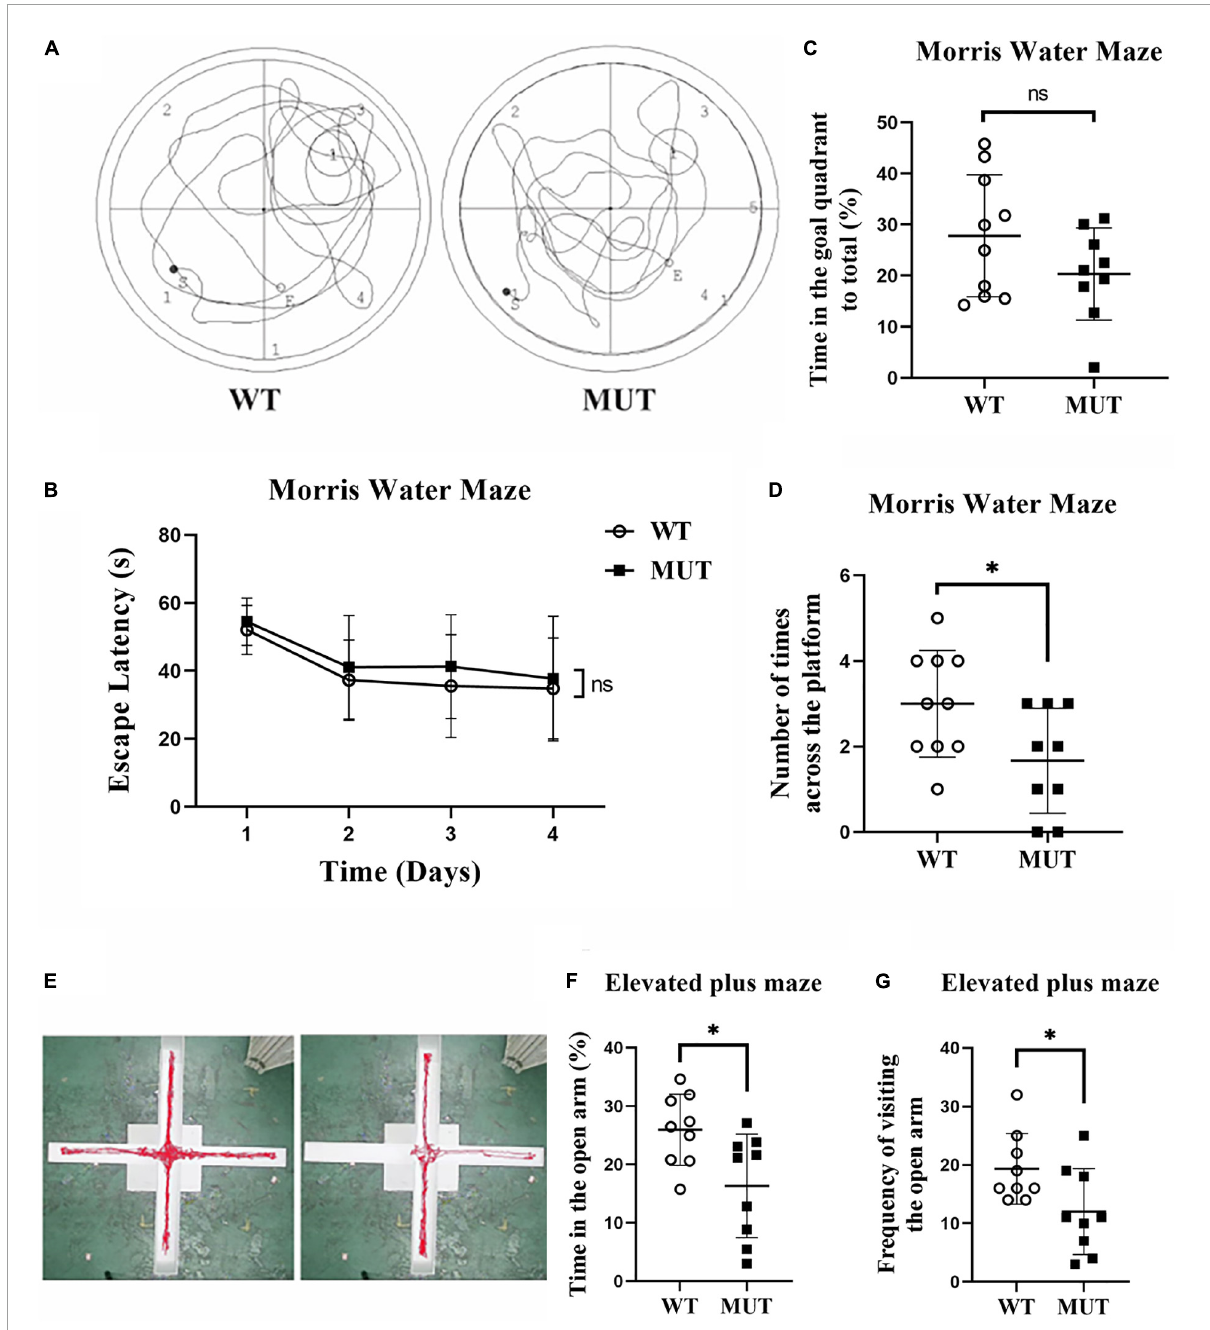
FIGURE4 Timm8a1 I 23 fs 49 X / I 23 fs 49 X MUT mice had impaired learning and anxiety-like behavior at 20 weeks of age. (A) Traveling trace in the Morris Water Maze test. (B) From day 1 to day 4 of training, all mice showed a gradual decline in the latency to find the hidden platform over time. (C) On the probe test day, there was no difference in the spent time in the goal quadrant between the two groups (WT = 27.83 ± 11.95, n = 10; MUT = 20.34 ± 9.04, n = 9, p > 0.05) . (D) On the probe test day, the MUT mice crossed less frequently in the platform area than the wild-type (WT) mice (WT = 3.00 ± 1.25, n = 10; MUT = 1.67 ± 1.22, n = 9, ∗ p < 0.05). (E) Trace of the WT and MUT mice in the elevated plus maze test for 5 min. (F) Elevated plus maze test. The MUT mice spent less time in the open arm than the WT mice (WT = 25.93 ± 6.11, n = 9; MUT = 16.32 ± 8.87, n = 9, ∗ p < 0.05). (G) Elevated plus maze test. The MUT mice visited the open arm less frequently than the WT mice (WT = 19.33 ± 6.02, n = 9; MUT = 12.00 ± 7.33, n = 9, ∗ p < 0.05). Error bars represent mean ±